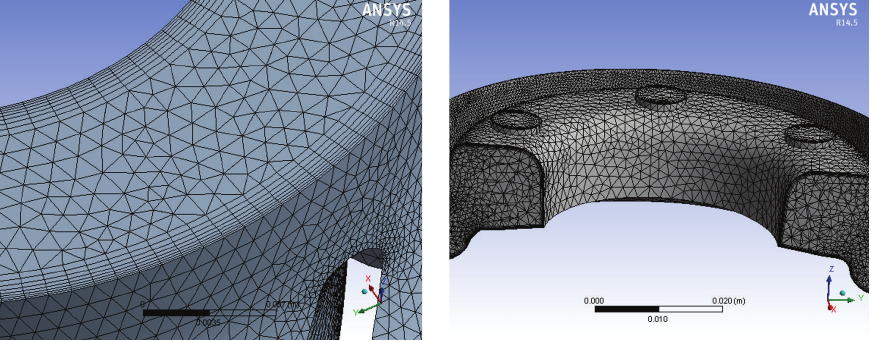
Figure 4: Mesh configuration used for flow analysis.